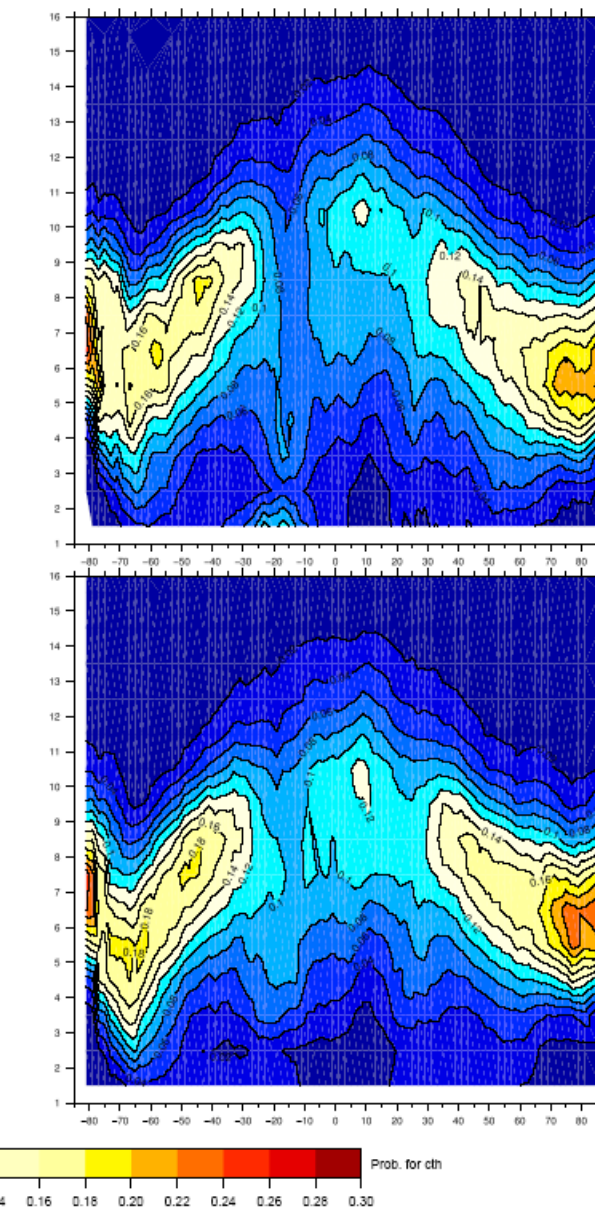
Figure 4. The probability plot of cloud top height (CTH) for 2003–2006 (Top: 2003 (left) and 2005 (right), Bottom: 2004 (left), 2006 (right)). OX: latitude (degrees), OY:CTH